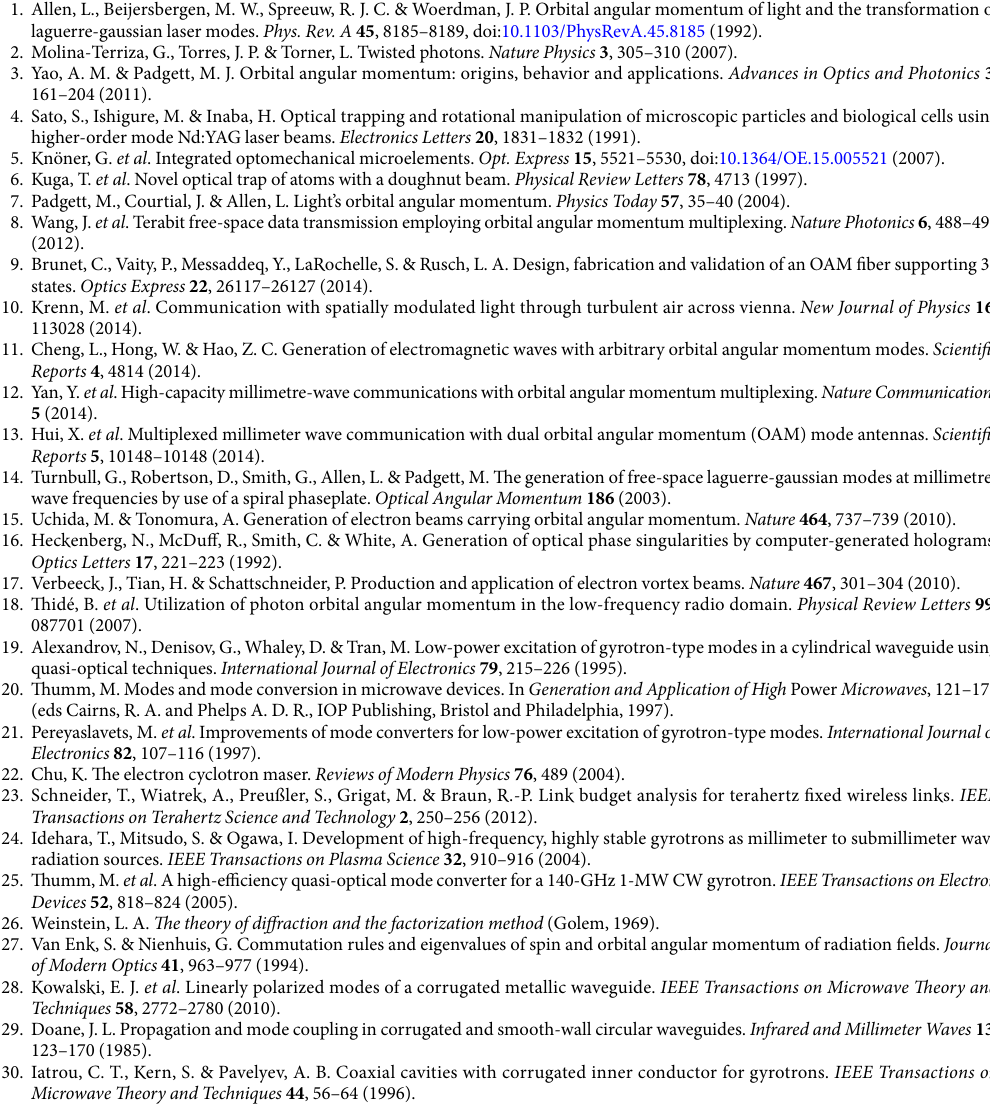
Fig. 6. The amplitude and phase patterns consist of two circular rings and 5 spirals, respectively, which assures the existence of a rotating TE 6,2 mode at 95.29 GHz. Similarly, at 98.6 GHz, the measured amplitude pattern contains a single circular ring close to the cavity wall, and the measured phase pattern contains nine spirals, which confirm the TE 10,1